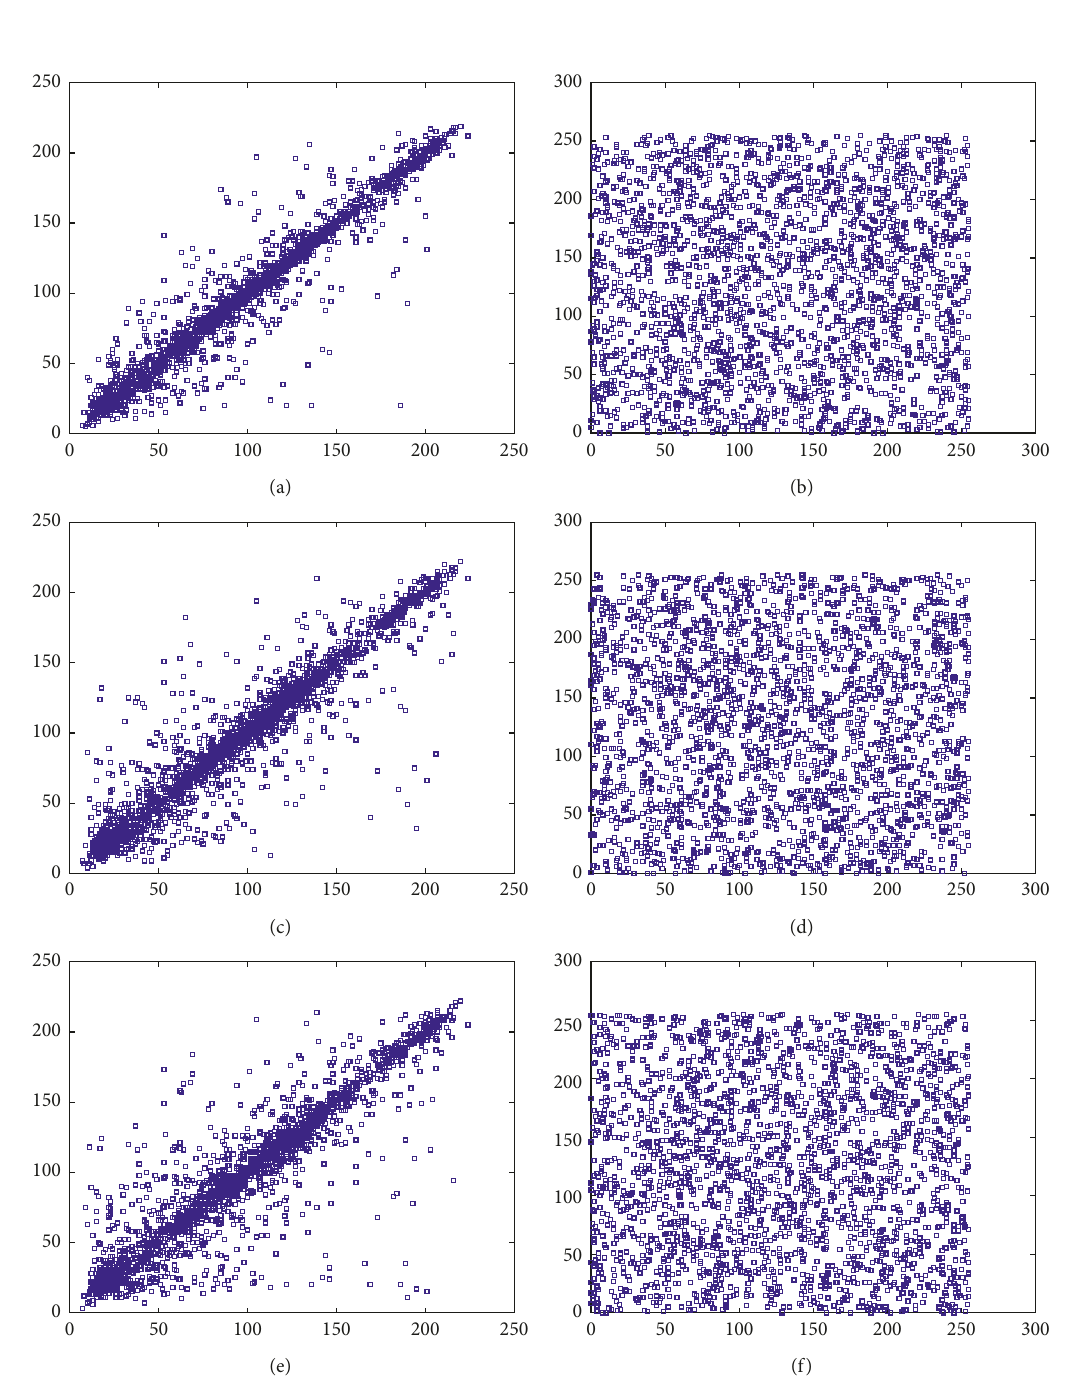
Figure 18: Correlation analysis of image: (a) plain image in horizontal; (b) cipher image in horizontal; (c) plain image in vertical; (d) cipher image in vertical; (e) plain image in diagonal; (f) cipher image in diagonal.